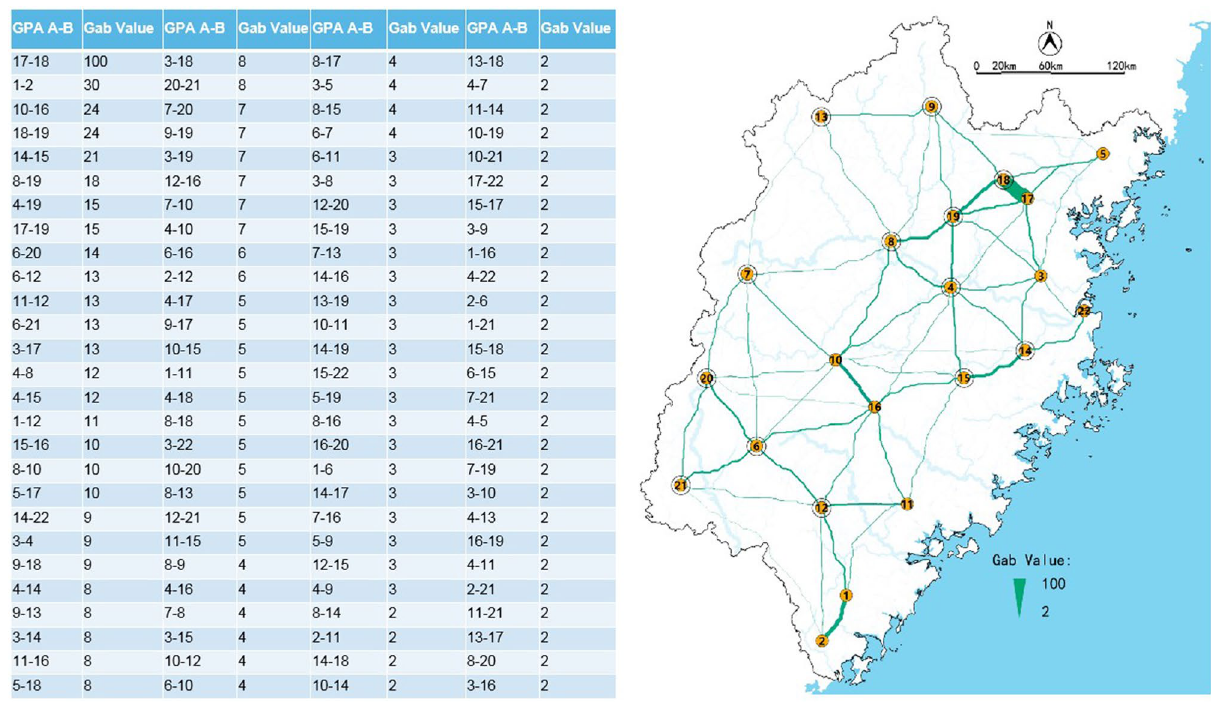
Figure 16. Ecological candidate networks in Fujian